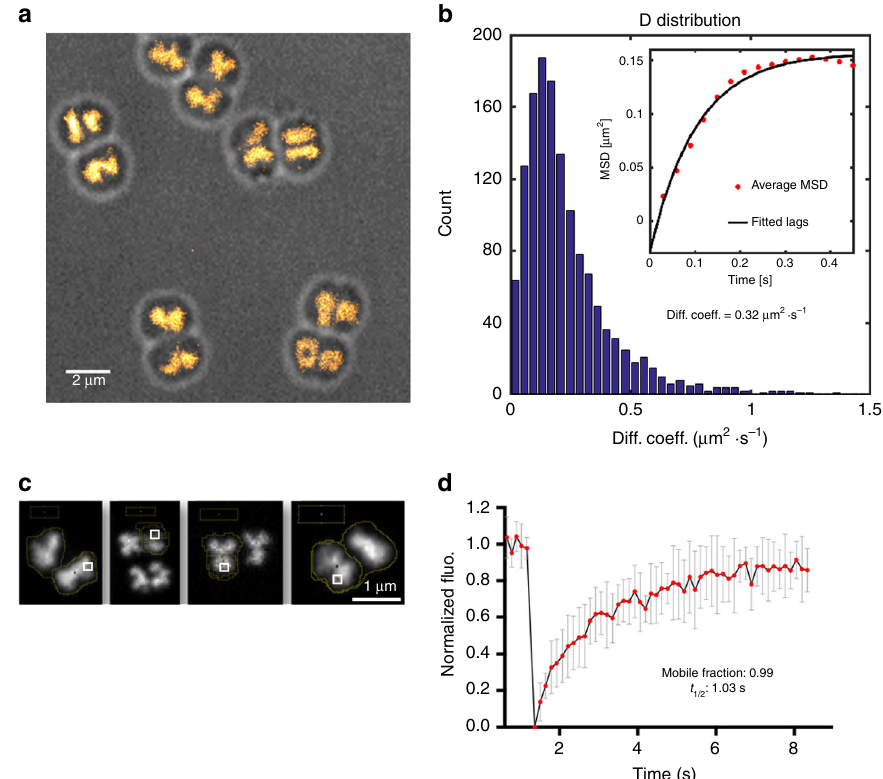
Fig. 5 Nucleoid and HU dynamics in live D. radiodurans . a Reconstructed PALM image of HU-PAmCherry-expressing cells (stack of 15,000 frames with 50 ms frametime and acquired with constant 1 kW cm − 2 561 nm laser and increasing 405 nm laser power). Several of the nucleoid morphologies illustrated in Fig. 3 can be seen in this image, but without a signi fi cative improvement in the perceived spatial resolution, due to the dynamics of nucleoids in live cells that change conformation in the second-to-minute timescale (Supplementary Movie 5). b Distribution of the apparent diffusion coef fi cients of 1355 single tracks of HU-PAmCherry measured by single-particle-tracking PALM in live, exponentially growing HU-PAmCherry-expressing D. radiodurans . Inset: mean square deviation (MSD) plot of the HU-PAmCherry tracks ( Δ t = 30 ms). The curve indicates that the molecules are con fi ned with a con fi nement radius of 400 nm. The mean apparent diffusion coef fi cient derived from these 1355 tracks is of 0.32 µ m 2 /s. c , d Ensemble measurements of HU-mCherry mobility probed by fl uorescence recovery after photobleaching (FRAP) on HU-mCherry-expressing live D. radiodurans cells. c Examples of HU-mCherry-labelled nucleoids used for FRAP experiments. The photobleached region (ROI1) is indicated with a white box. Scale bar: 1 µ m. d Analysis of the recovery of the fl uorescence signal of HU-mCherry after photobleaching. Fitting this full-scale normalized data reveals that 99 ± 1% of HU-mCherry molecules are mobile exhibiting a half-life of 1.03 ± 0.06 s. Presented data are the mean values ± SD ( N = 10). Source data are provided as a Source Data fi